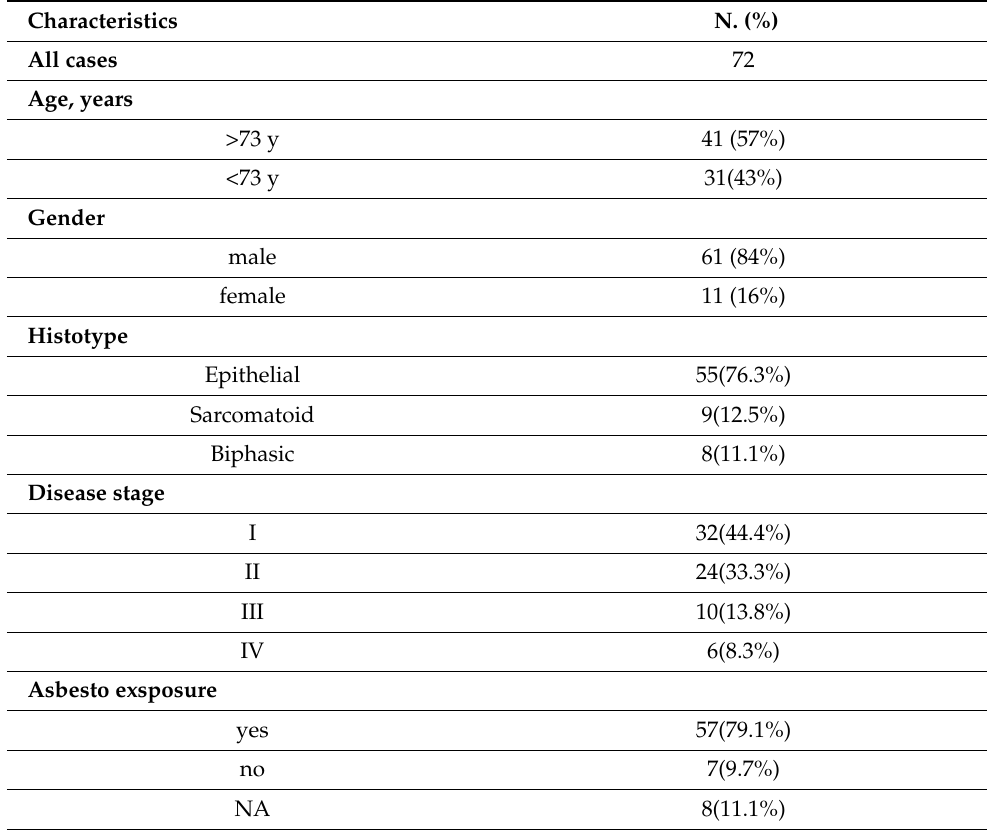
Table 1. Clinical and pathological features of